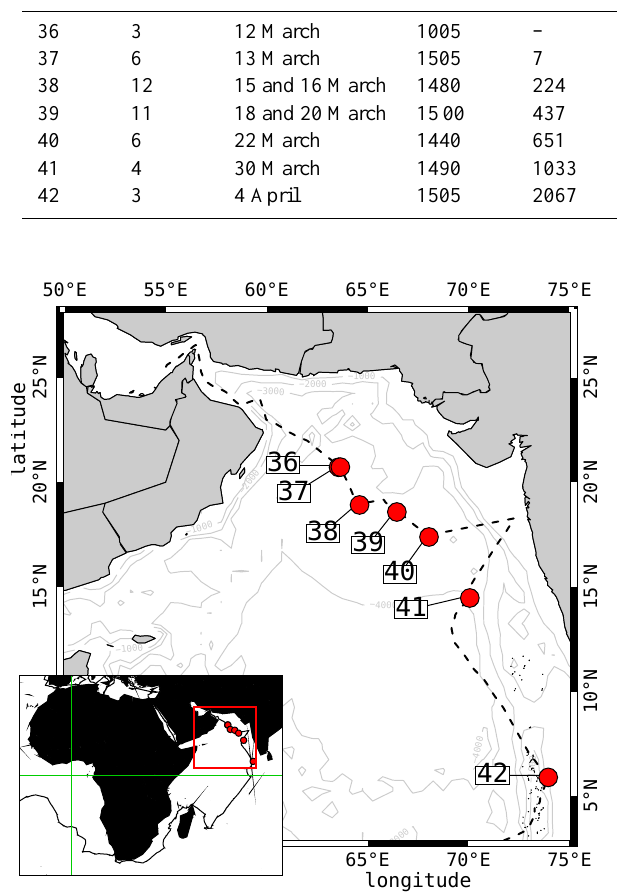
Figure 1. Map of the Arabian Sea (northwestern Indian Ocean) showing the TARA transect and the seven sampled stations (sta- tions 36 to 42). Station 42 is out of the Arabian basin, located near Maldives Island, and is used as a reference point without